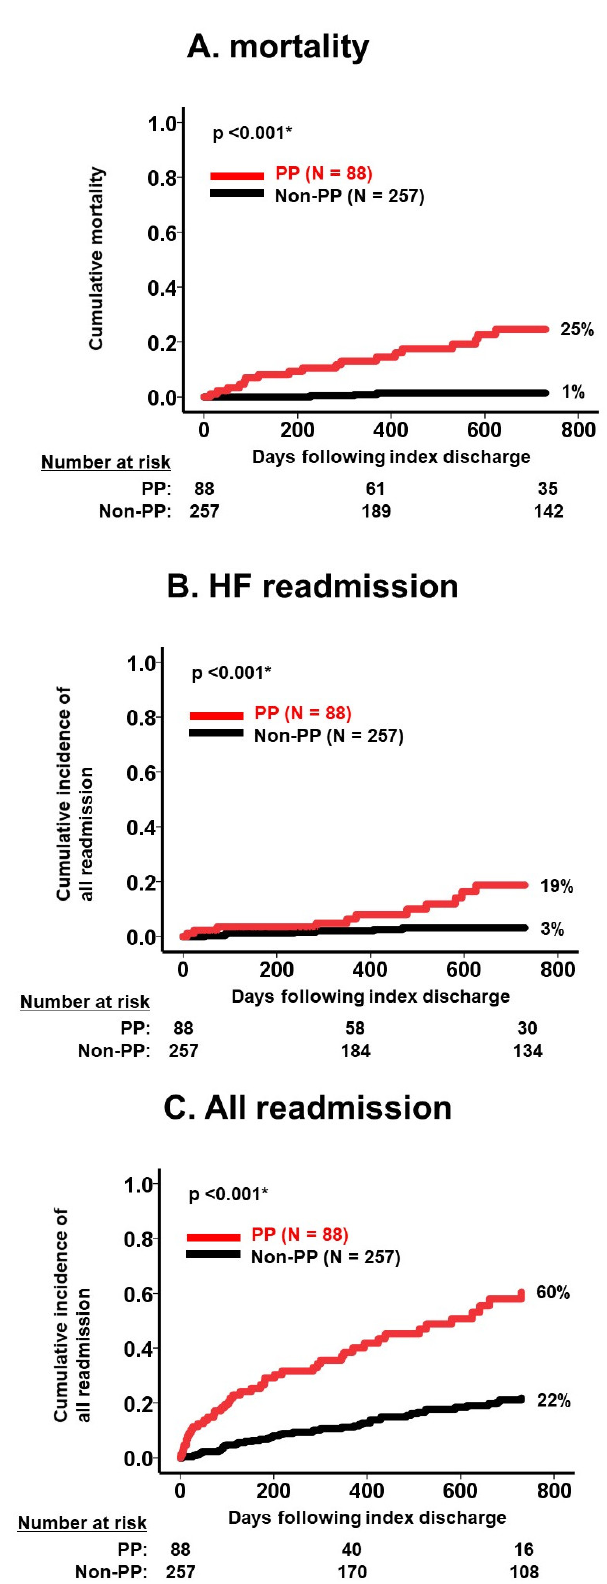
Figure 3. Cumulative incidence of death ( A ), HF readmission ( B ), and all readmission ( C ) stratified by PP versus non-PP. Cumulative incidences of each clinical outcome were significantly stratified by polypharmacy. HF, heart failure; PP, polypharmacy. Incidences were compared between the two groups using log-rank test. * p < 0.05. As a sub-analysis, the number of cardiovascular medications was not associated with 2-year mortality (hazard ratio 1.12, 95% confidence interval, 0.86–1.48, p = 0.46), whereas a higher number of non-cardiovascular medications was associated with an incremental increase in 2-year mortality, with a hazard ratio of 1.39 (95% confidence interval, 1.15– 1.63, p < 0.001). The number of potentially inappropriate medications tended to be associ- ated with 2-year mortality (hazard ratio 1.14, 95% confidence interval 0.82–1.32, p = 0.076).